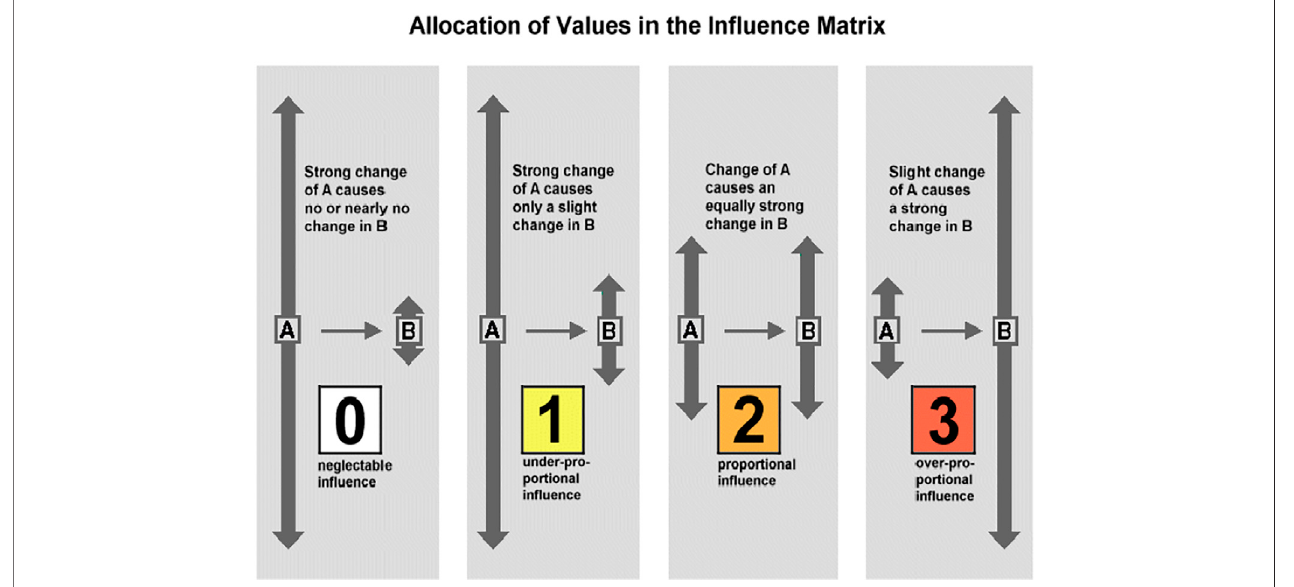
FIGURE 2 | Meaning of number values in impact